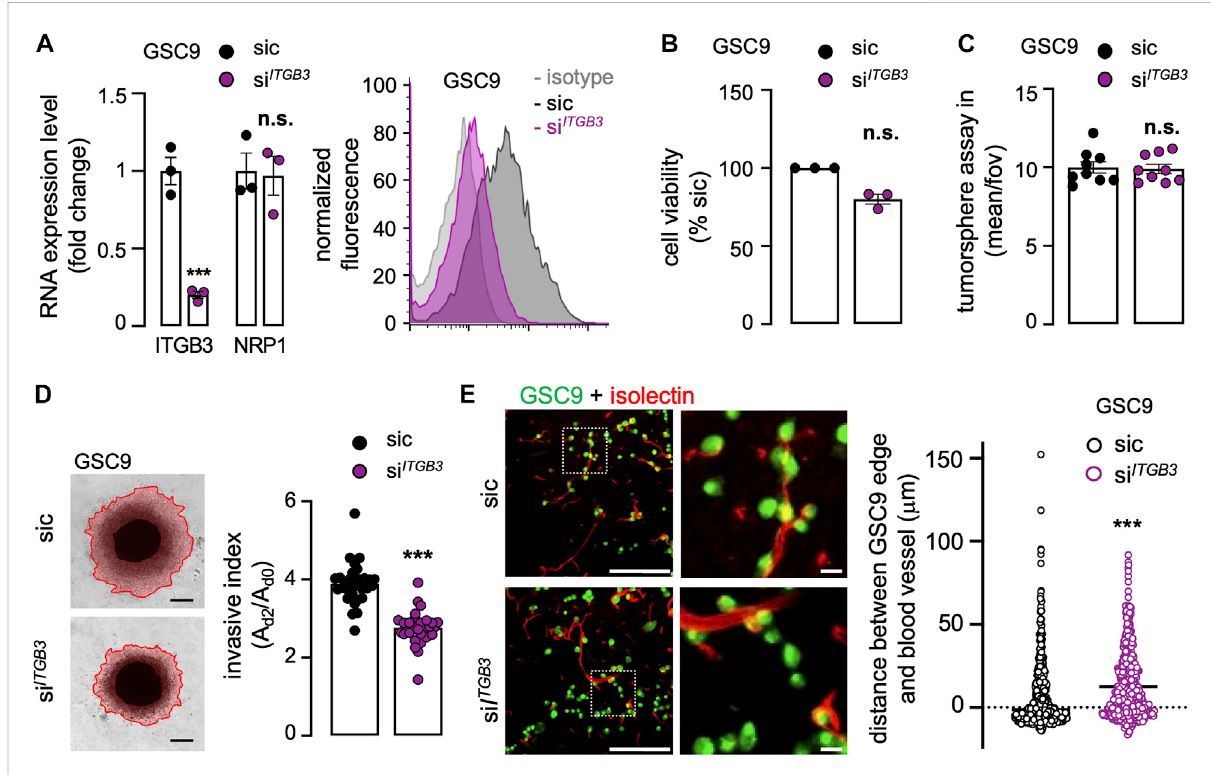
FIGURE 4 ITGB3 silencing recapitulates the NRP1 de fi ciency phenotype in patient-derived GSCs. GSC9 were transfected with non-silencing (sic, black) and ITGB3 targeting duplexes (si ITGB3 , purple). (A) The knockdown ef fi ciency was evaluated 72 h later at the RNA (left panel) and protein level (right panel). Alternatively, NRP1 mRNA level was analyzed. qPCR analysis of ITGB3 and NRP1 mRNA is shown as the mean ± s.e.m. fold change from three independent experiments using ACTB and HRPT1 as housekeeping genes for normalization (left panel). Representative plots of fl ow cytometry analysis show the staining of isotype control (light grey), sic (dark grey), and si ITGB3 (purple) (right panel). (B) Cell viability was measured using CellTiterGlo on day 3. Data were normalized to sic and are presented as the mean ± s.e.m. of three independent experiments in triplicate. (C) Tumorspheres per fi eld of view (fov) were single-blinded and manually counted. Data are presented as the mean ± s.e.m. from three independent experiments in triplicate. (B) Representative images and quanti fi cation of invasion assay in collagen embedded-spheroids at day 3. Scale bars: 300 μ m. Data are presented as the mean ± s.e.m of the invasive index on 29 – 31 spheroids from three independent experiments. (E) Representative confocal analysis of the co-culture between GSCs (green) and mouse brain. The distance between the edge of each GSC and the nearest blood vessel (red) was further quanti fi ed. Representative of two independent experiments (n > 522). Scale bars: 200 μ m, 20 μ m. All panels are representative of at least three independent experiments unless otherwise stated, t -test and ANOVA, ** p < 0.01, *** p <